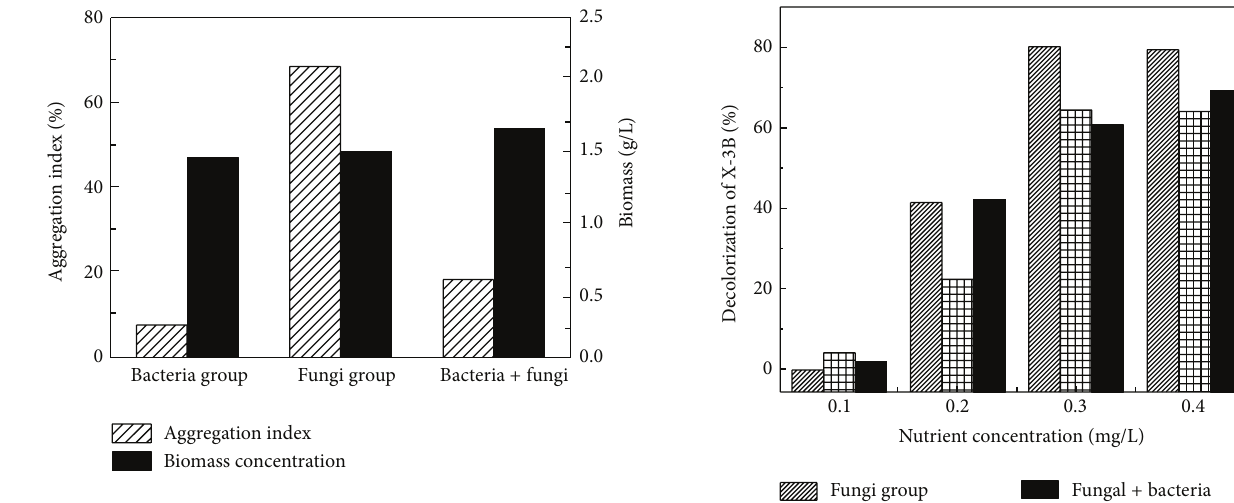
Figure 2: Aggregation indexes and biomass concentrations of the bacteria group, fungi group, and bacteria-fungi coculture at the stationary phase. Figure 3: Reactive red X-3B decolorization efficiencies at different nutrient levels (each concentration of (NH 4 ) 2 SO 4 , KH 2 PO 4 , and K 2 HPO 4 is 0.1, 0.2, 0.3, and 0.4 mg/L) for the bacteria group, fungi group, and bacteria-fungi coculture at the stationary